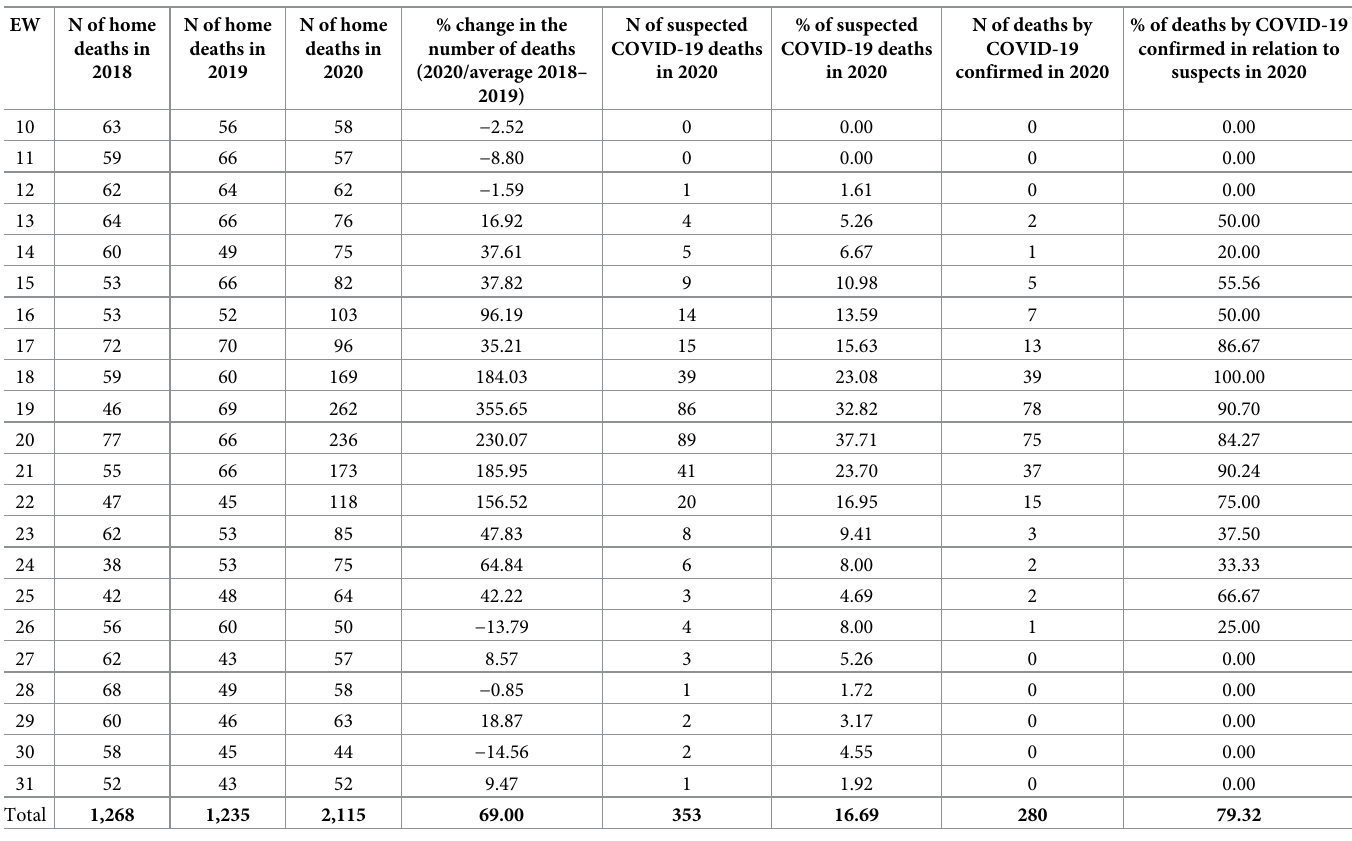
Table 1. Deaths at home in Fortaleza, State of Ceara´, attended by SVO-RF in 2018, 2019, and 2020, suspicious and confirmed home deaths by COVID-19 in